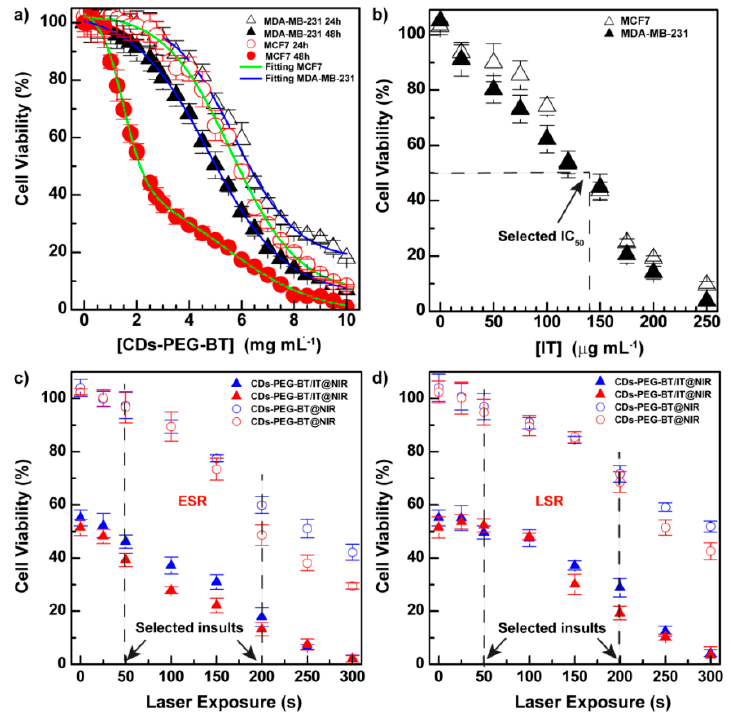
Figure 4. 3-(4,5-dimethylthiazol-2-yl)-5-(3-carboxymethoxyphenyl)-2-(4-sulfophenyl)-2H-tetrazolium (MTS) assay on MCF7 and MDA-MB-231 cell lines. Cytocompatibility of CDs-PEG-BT on MCF7 and MDA-MB-231 cells after 24 and 48 h incubation. ( a ) dose–response or bi-dose–response fitting (R 2 > 0.997) is reported in green and blue for MCF7 and MDA-MB-231 cells, respectively. Anticancer e ff ect of CDs-PEG-BT / IT as function of equivalent amount of drug; ( b ) NIR-triggered anticancer photothermal e ff ect of either the CDs-PEG-BT / IT and equivalent amount of the bare CDs-PEG-BT on MCF7 (red) and MDA-MB-231 (blue) cells at the IC50 calculated in Figure b (IT = 140 µ g mL − 1 ≡ CDs-PEG-BT = 590 µ g mL − 1 ) and low power density (2 W cm − 2 ); ( c – d ): early stage response (ESR) is evaluated before the treatment ( c ), whereas long stage response (LSR) is evaluated 20 h after the photothermal insults ( d ). Data shown as mean ± s.e.m. ( n = 3, two independent